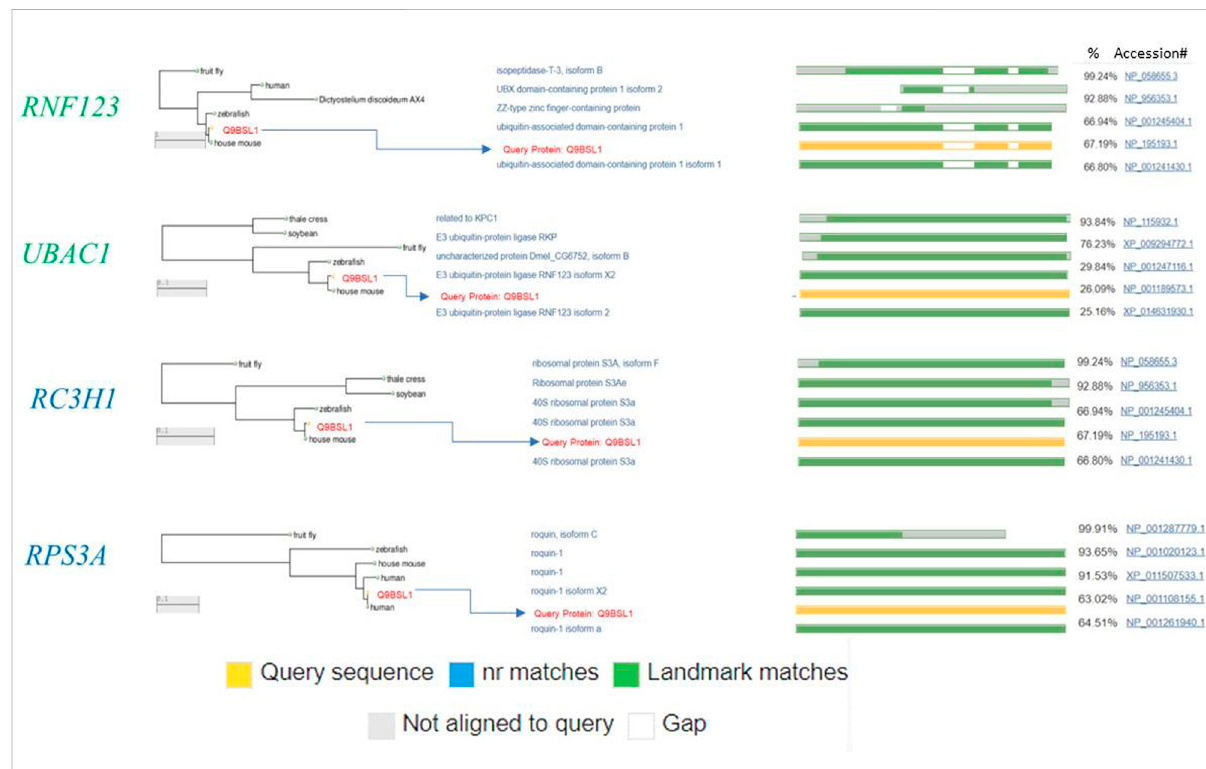
FIGURE 11 Conservational Analysis of RNF123, UBAC1, RC3H1, and RPS3A genes. Multiple protein sequence alignment and Phylogenetic tree was performed by SmartBLAST. Parentheses refers to the percent sequence of identity of the reference sequence.